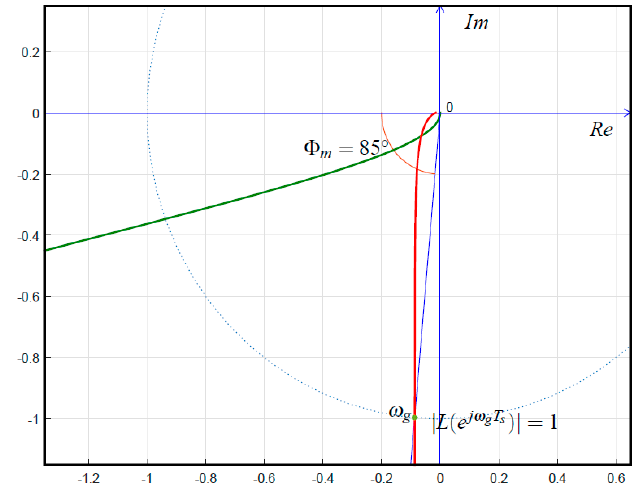
Figure 3. The Nyquist plot of the frequency response of the buck converter (green), and of the open loop frequency response with the discrete-time inversion formulae (red).